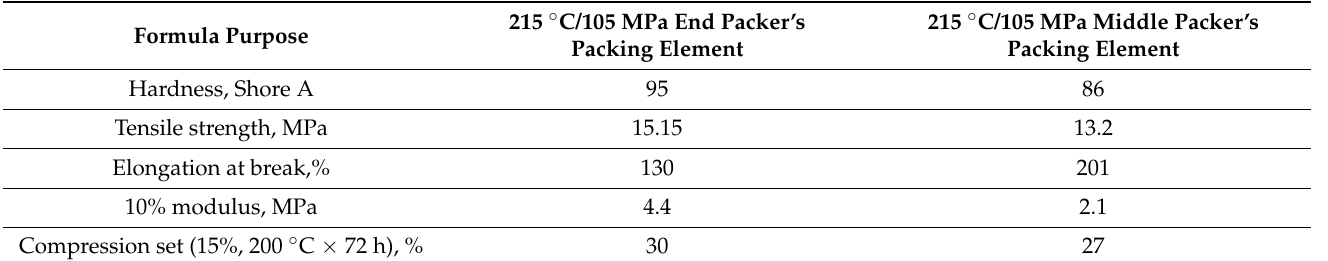
Table 2. Parameters of the packer’s rubber packing element size for the 105 MPa/215 ◦ C